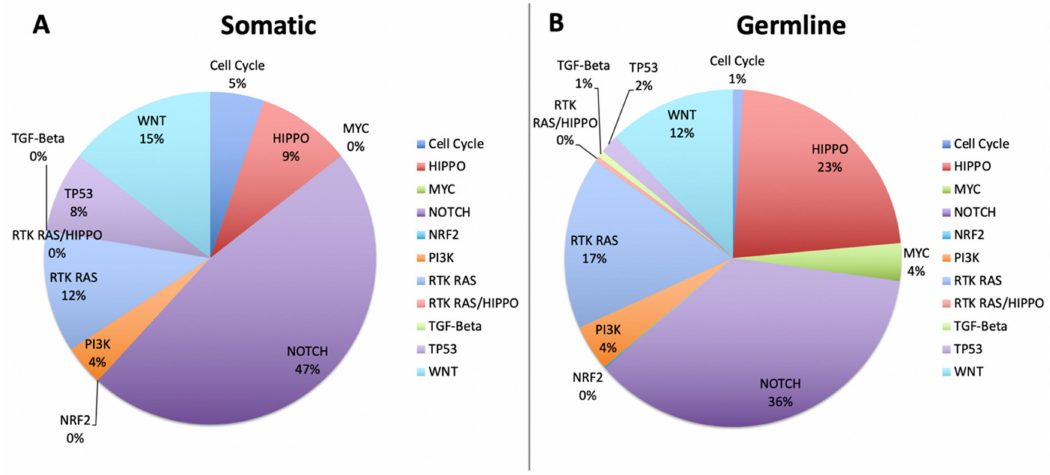
Figure 6. The percentages of both somatic and germline variants detected in the rare tumor cohort. The largest di ff erence between somatic and germline variants is seen in the increase of germline variants in the Hippo pathway (9% somatic vs. 23% germline).